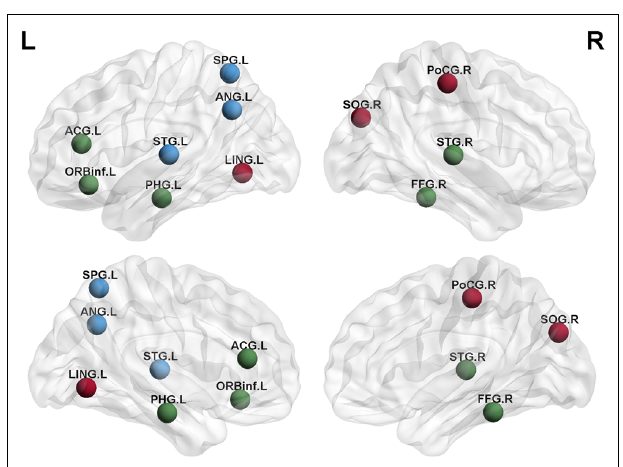
FIGURE 5 | Nodal degree of brain network. Results showed significantly different regions in the degree between APOE 4 − T − and the following groups: APOE 4+T+ (green nodes), APOE 4+T − (brown nodes), APOE 4 − T+ (blue nodes), after 5,000 permutation testing ( p < 0.05, FDR-corrected). Abbreviation: SPG.L, left superior parietal gyrus; ANG.L, left angular gyrus; STG.L, left superior temporal gyrus; ACG.L, left anterior cingulate and paracingulate gyri; ORBinf.L, left inferior frontal gyrus (orbital part); PHG.L, left parahippocampal gyrus; LING.L, left lingual gyrus; SOG.R, right superior occipital gyrus; PoCG.R, right postcentral gyrus; STG.R, right superior temporal gyrus; FFG.R, right fusiform gyrus.